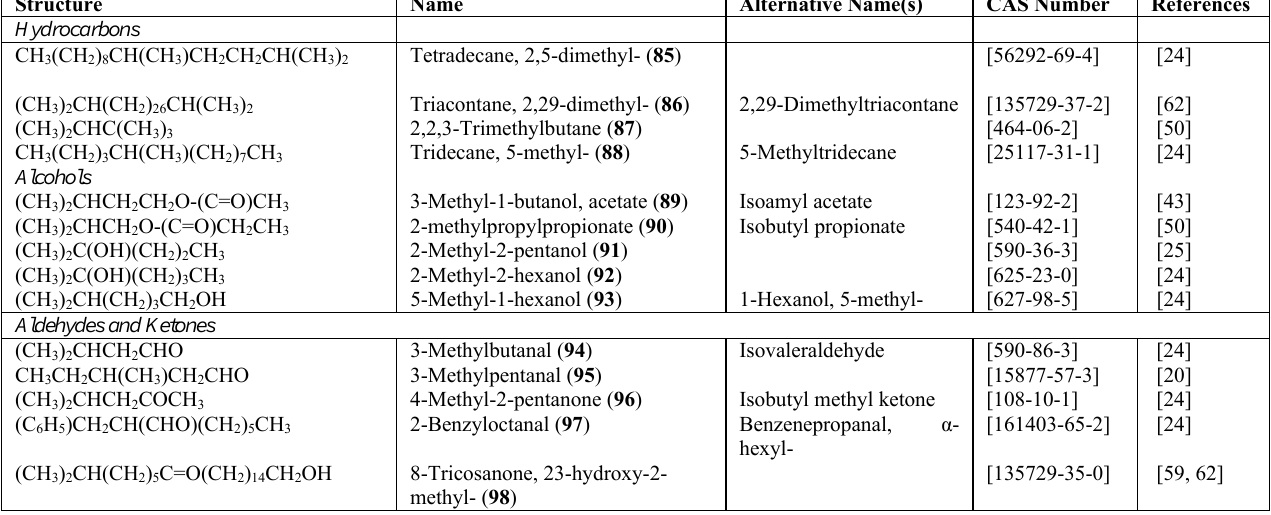
Table 6. Branched Aliphatic Hydrocarbons and Alcohols.